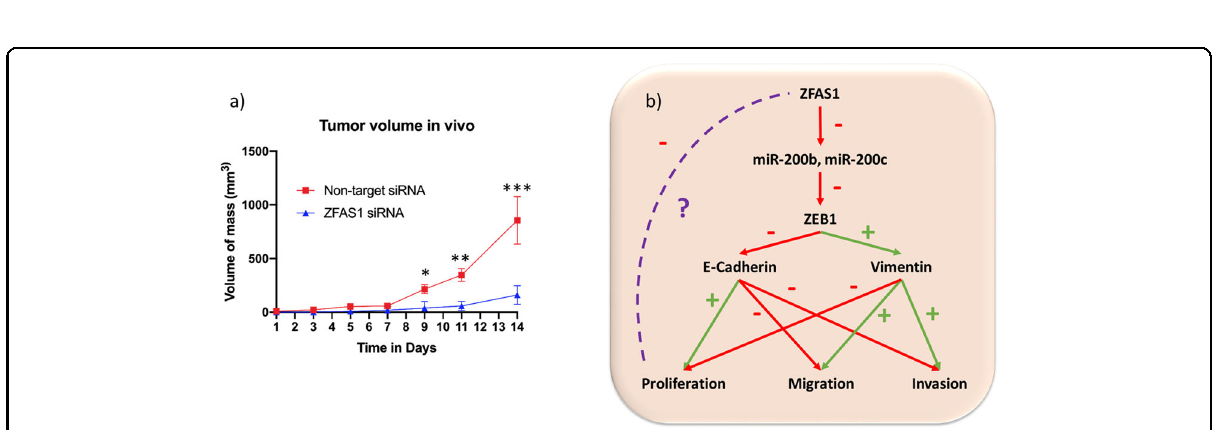
Fig. 7 ZFAS1 knockdown is associated with decreased tumor growth in vivo compared to not-target siRNA. a ZFAS1 knockdown was associated with decreased tumor volume in a mouse xenograft model compared to non-target siRNA, with signi fi cant differenes observed from day 3 after mass was fi rst identi fi ed in each mouse. The differences were most pronounced from day 7 up until day 14 when the experiment was terminated ( N = 4 replicates) (* p = 0.006, ** p < 0.001, *** p = 0.024). b Illustration of the signaling cascade demonstrated by these